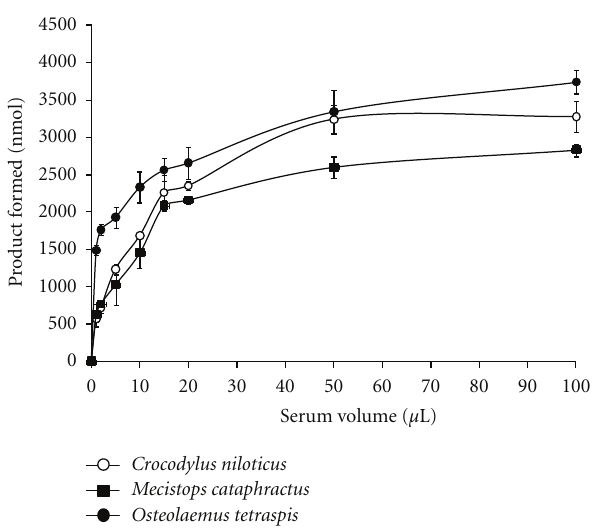
Figure 1: Serum volume-dependent PLA 2 activity in Osteolaemus tetraspis , Mecistops cataphractus , and Crocodylus niloticus . The results represent the means ± standard deviations of four indepen- dent determinations.